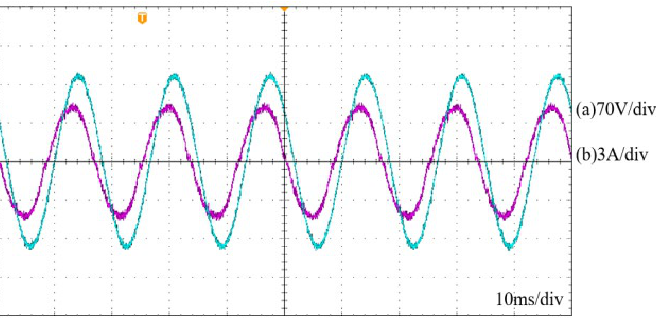
Figure 13. Experimental results of BBI for supplying leading current, ( a ) power grid voltage, ( b ) output current.